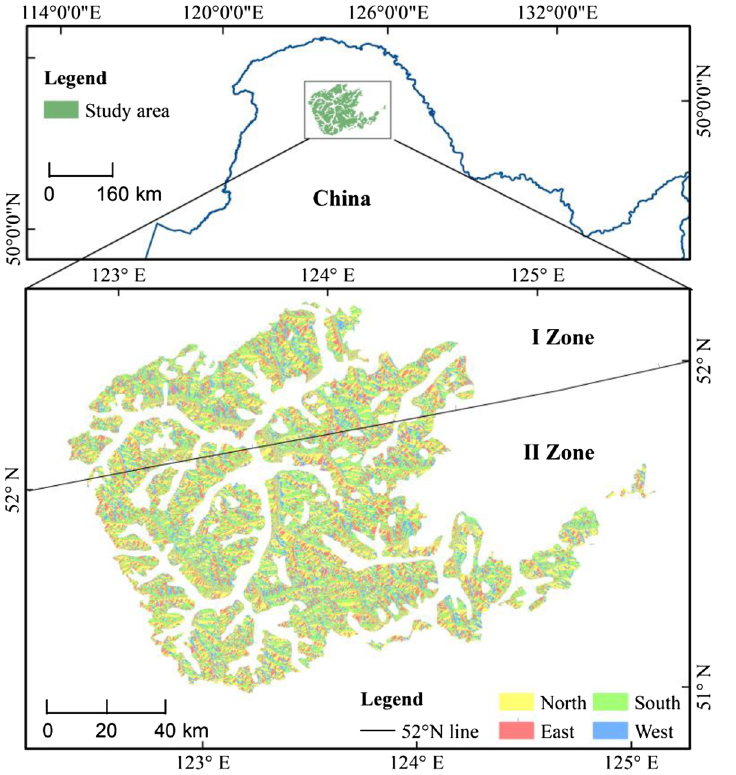
Figure 1. Location and the aspect division of study area.